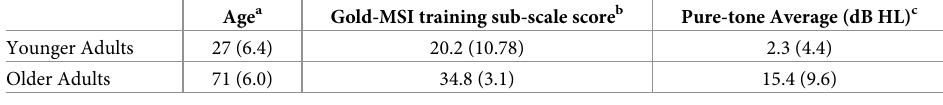
Table 5. Participant demographics–Experiment